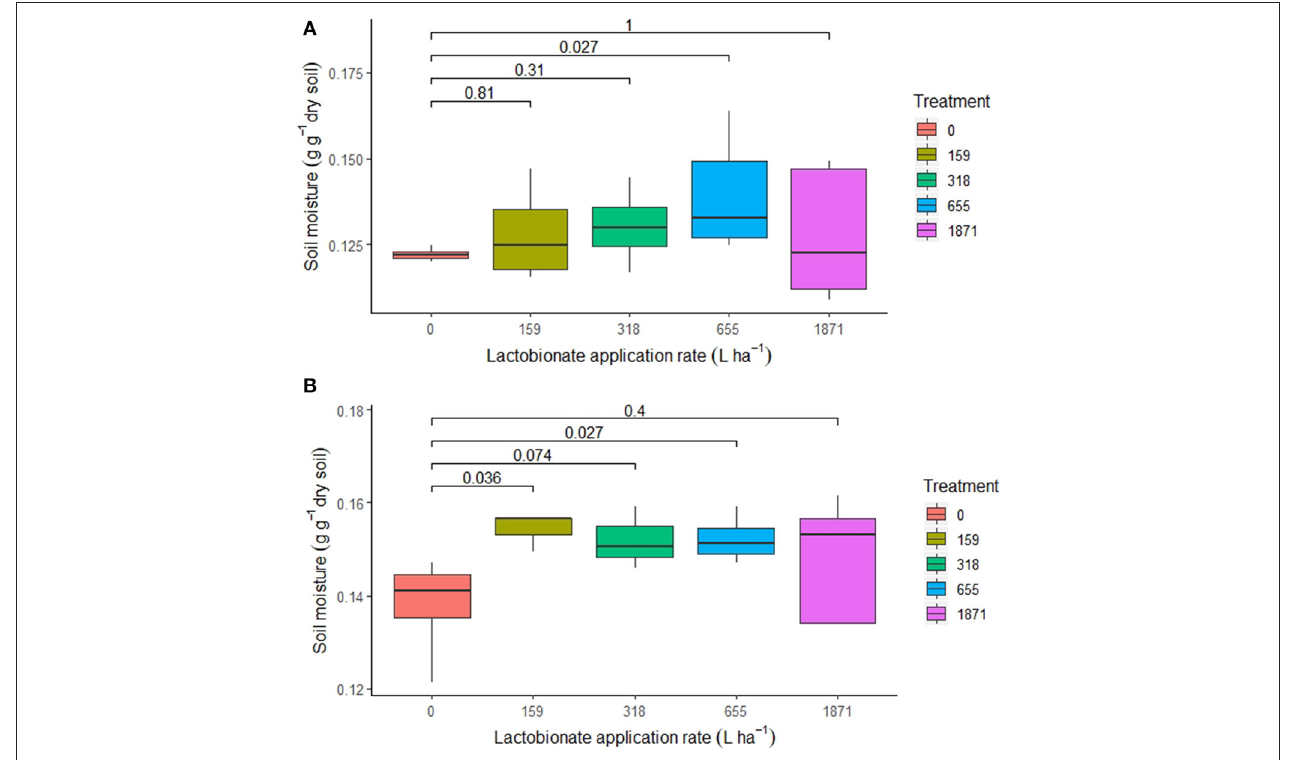
FIGURE 3 | (A) Effect of lactobionate application on gravimetric soil moisture for wheat trial (0–5cm). (B) Effect of lactobionate application on gravimetric soil moisture for wheat trial (5–15cm). Horizontal lines and p -values above each boxplot is the pairwise comparison of each treatment and control.